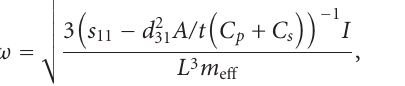
of ME composites in magnetic field sensing; that is, large dimensions are required to achieve low EMR